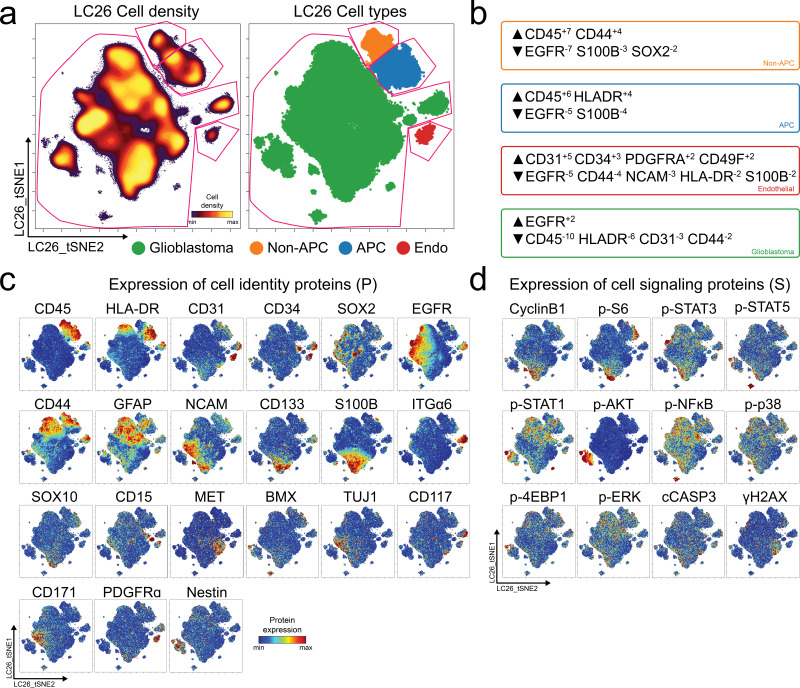
Single cell quantification of identity proteins and phospho-protein signaling in glioblastoma.(a) t-SNE plots of cell density (left) and major cell types in a patient tumor (LC26) colored by expert gating (right) for antigen presenting cells (APC, blue), other immune cells (non-APC, orange), endothelial cells (Endo, red), and glioblastoma cells (green) using CD45, CD31, and HLA-DR to identify cells. Pink lines indicate where expert gates were drawn. (b) MEM protein enrichment scores for populations indicated by color in (a), using the other three populations as reference. (c) Per-cell expression levels of 21 identity proteins, (d) 9 phosphorylated signaling effectors, proliferation marker cyclin B1, apoptotic signaling factor cleaved caspase 3 (cCASP3), and DNA damage marker γH2AX in LC26 are depicted. Heat indicates protein or phospho-protein expression per cell; scale is specific to each measured feature.